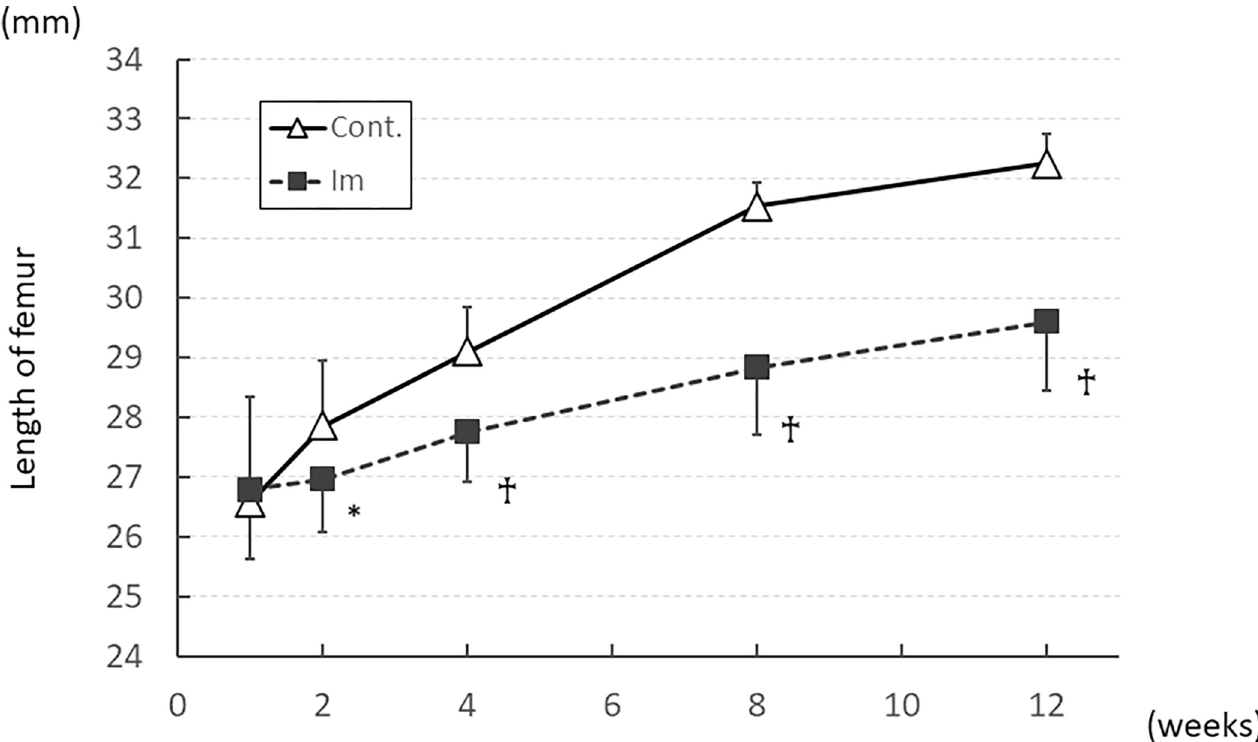
Fig 2. Temporal changes in length of the femur (trochanter-malleolar distance). Length of the femur was significantly shorter in the Im group than in the control group after 4 weeks, and this situation continued until the end of the experiment. † P < 0.01 compared to control group. � P < 0.05 compared to control